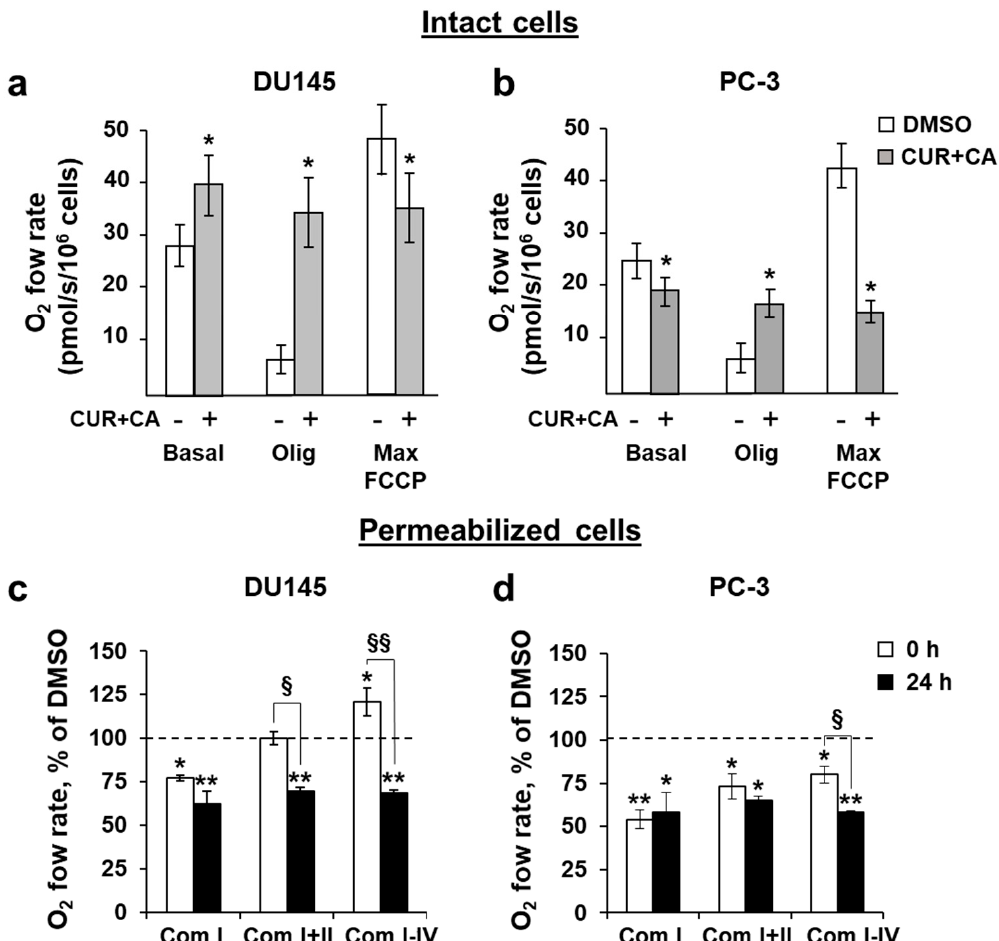
Figure 7. Combinatory effects of curcumin and carnosic acid on OxPhos. ( a , b ) Oxygen consumption in the presence or absence of 7 µ M CUR and 5 µ M CA (CUR + CA). Abbreviations: Basal, basal respiration; Olig, oligomycin-inhibited respiration; Max FCCP, the maximal respiratory capacity of mitochondria. ( c , d ) Respiration of permeabilized cells. The state 3 rates of OxPhos of complexes I, I+II, and I-IV measured upon addition (0 h) and after incubation (24 h) with the combination of CUR and CA, as compared to DMSO-treated cells. Data are presented as mean ± SEM ( n = 3). Statistically significant differences in intact cell groups ( a , b ) treated with CUR + CA vs. DMSO: * p < 0.05. In permeabilized cell groups ( c , d ), statistically significant differences for the indicated groups vs. DMSO: * p < 0.05 and ** p < 0.01). § p < 0.05 and §§ p < 0.01, significant difference between the two indicated groups (Student’s t